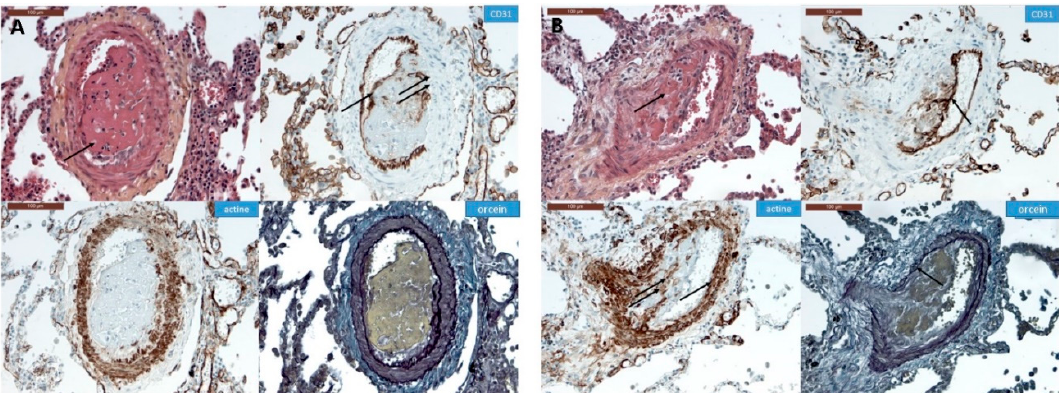
Figure 9. Immunohistochemistry of Stage I and Stage II angiophagy in humans: a patient with CTEPH (axial cut). ( A ) (Stage I): Hematein–eosin–saffron (HES) staining shows an intraluminal thrombus (arrow, left upper panel). CD31 staining of the endothelial cells (right upper panel) shows that the thrombus is separated from the lumen by a layer of endothelial cells (single arrow); meanwhile, the thrombus is in direct contact with the smooth muscle cells (double arrow). The smooth muscle cell layer stained with anti-actin antibodies (left lower panel) and the elastic lamina stained with fuchsin– resorcin (orcein, right lower panel) remain intact. ( B ) (Stage II): Hematein–eosin–saffron coloration (left upper panel) shows a thrombus in the pulmonary artery wall (arrow). The thrombus is covered by endothelial cells (arrow, CD31 staining, right upper panel). The smooth muscle cell layer of the media is disrupted at the contact with the thrombus (double arrow, actin staining, left lower panel), whereas it remains intact at the opposite side of the pulmonary artery (single arrow, left lower panel). The fuchsin–resorcin staining (right lower panel) shows an intact elastic lamina at contact with the thrombus (arrow).